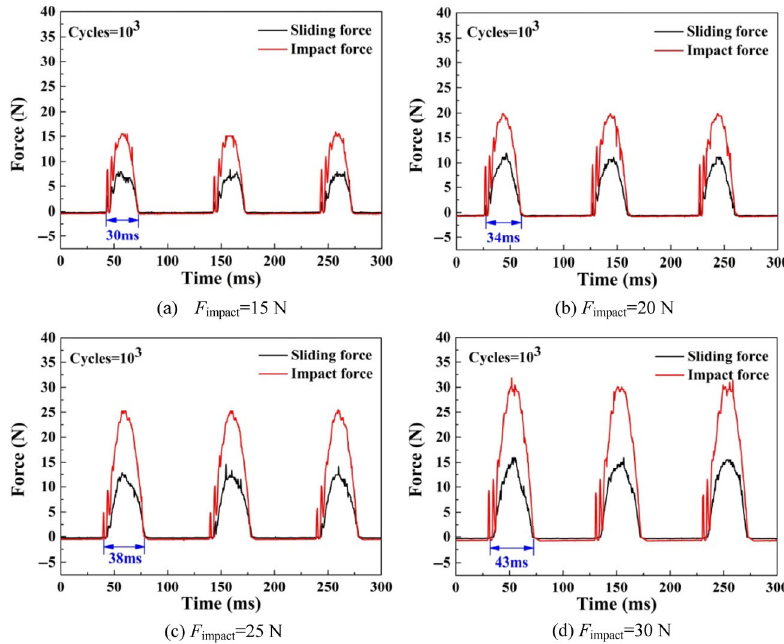
Fig. 17 Force-time curve under varied impact